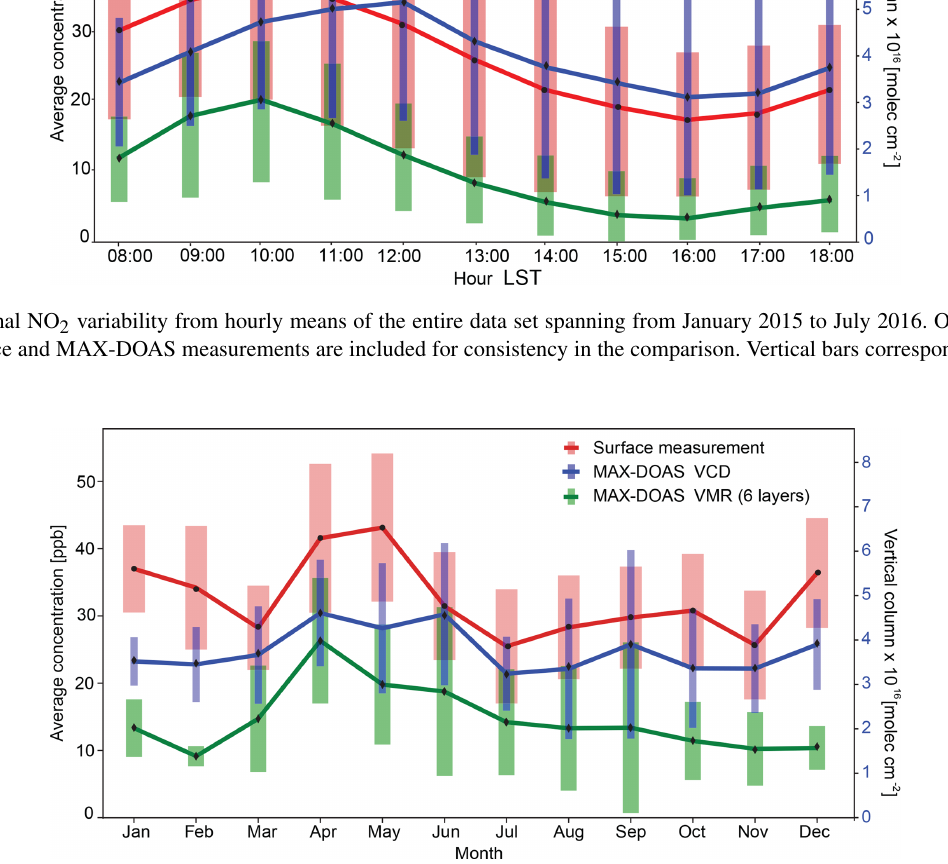
Figure 12. Annual NO 2 variability resulting from the monthly mean coincident data (surface and MAX-DOAS) between January 2015 and July 2016. The standard deviations are given in vertical